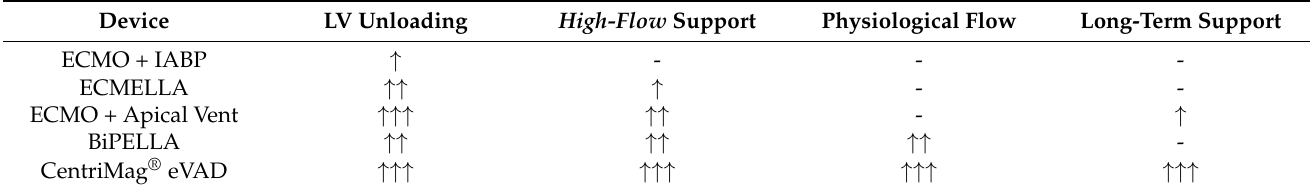
Table 5. LV unloading